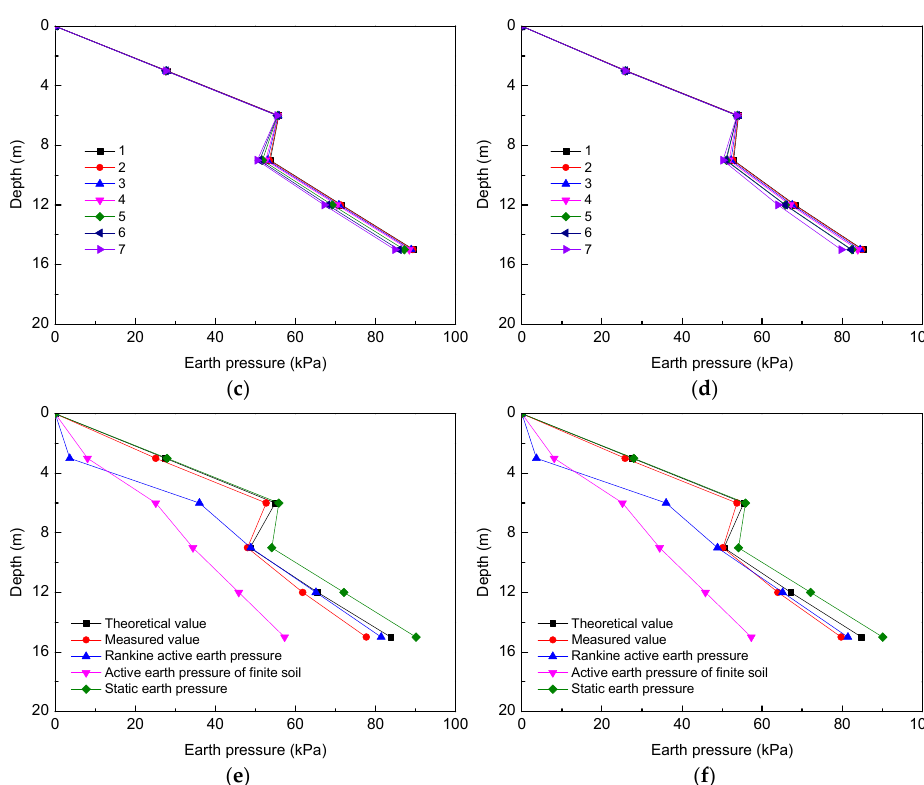
Figure 8. Earth pressure of finite soil: ( a ) Theoretical value (No. 1 pile); ( b ) Measured value (No. 1 pile); ( c ) Theoretical value (No. 2 pile); ( d ) Measured value (No. 2 pile). ( e ) Comparison of earth pressure (No. 1 pile); ( f ) Comparison of earth pressure (No. 2